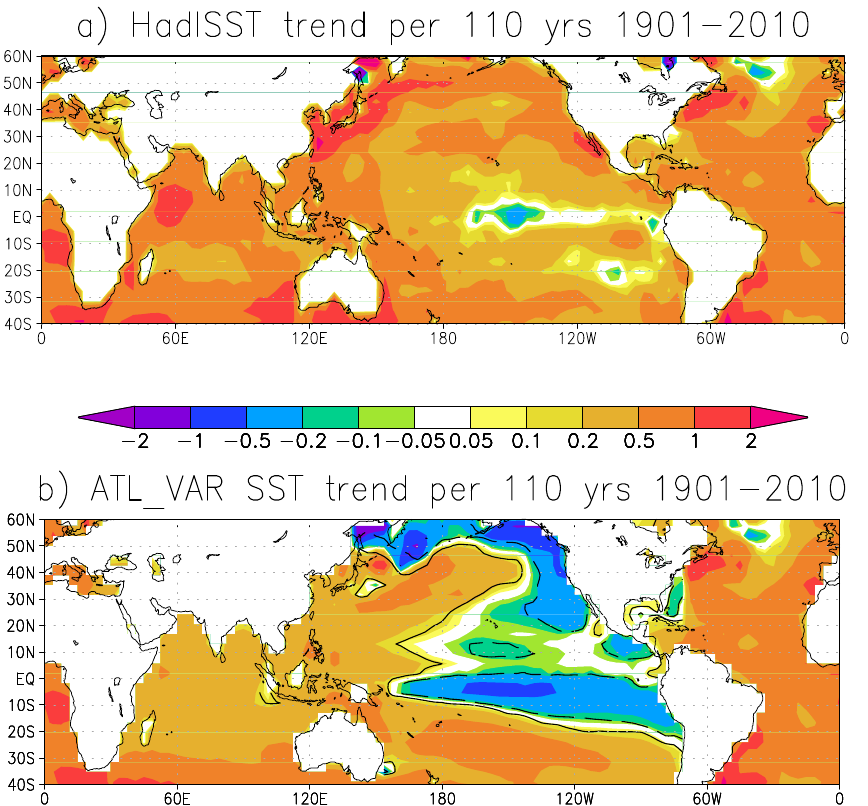
Figure 15. Linear SST trend for the period 1901 to 2010 per 110 years for ( a ) observed and ( b ) ATL_VAR. In ( b ), anomalies that are 95% statistically significant are indicated by contours. Units are